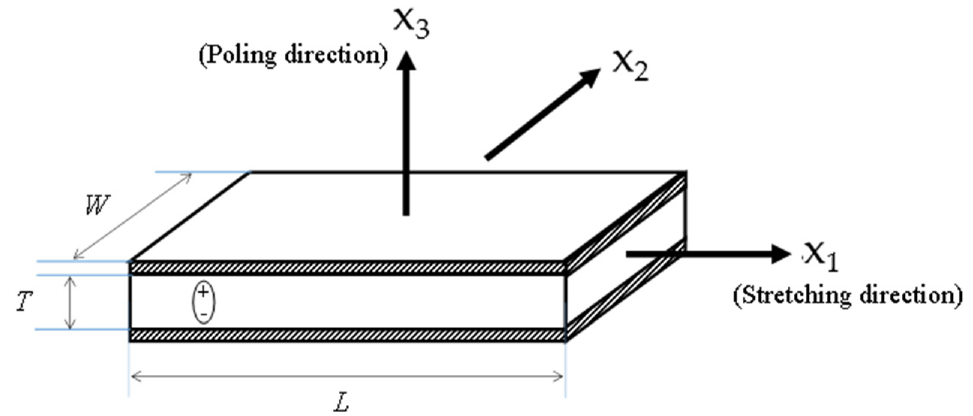
Figure 1. Schematic of the PVDF film used. In the manufacturing process, the film has been polarized in the x 3 direction and stretched in the x 1 direction.